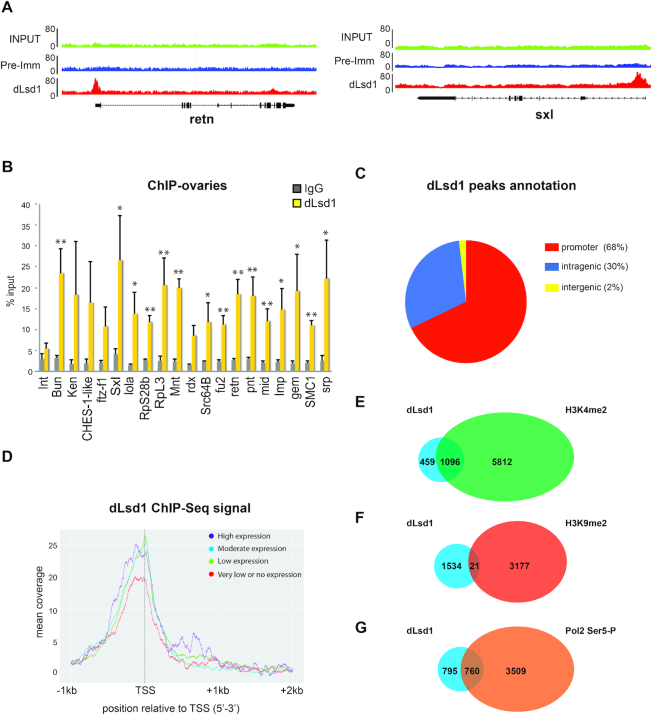
dLsd1 binding is enriched at TSS. (A) Integrated Genome Browser (IGB) screenshots of two dLsd1 enriched sites. Anti-dLsd1, pre-immune serum IP and input are shown. (B) ChIP-qPCR analysis of dLsd1 binding at a subset of genes identified as bound by dLsd1 in the ChIP-Seq dataset in wild-type (w1118) ovaries. IgG were used as a control for specificity. Int is an intergenic region used as negative control, and Bun is a previously identified dLsd1 target used as a positive control. The y axis represents enrichment as percent input. The ChIP experiments were performed in triplicate, and error bars indicate standard errors of the means. A Welch two-sample t-test was performed to indicate significance (*P < 0.05; **P < 0.01). (C) Genomic location of dLsd1 ChIP-Seq peaks. The promoter regions are defined as the sequences from 1KB upstream to 500bp downstream of the transcription start site (TSS). (D) dLsd1 ChIP-Seq read density around the TSS of genes classified as highly expressed, moderately expressed, lowly expressed and inactive (very low or no expression) according to the modENCODE RNA-Seq dataset in the ovary. Expression levels were estimated as reads per kilobase per million, rpkm. (E–G) Venn diagrams showing the number of common peaks between dLsd1 ChIP-Seq and H3K4me2 ChIP on chip (E), H3K9me2 ChIP on chip (F) and Polymerase 2 phosphorylated Serine 5 (Pol2 Ser5-P) ChIP-Seq (G) peaks in the ovary.